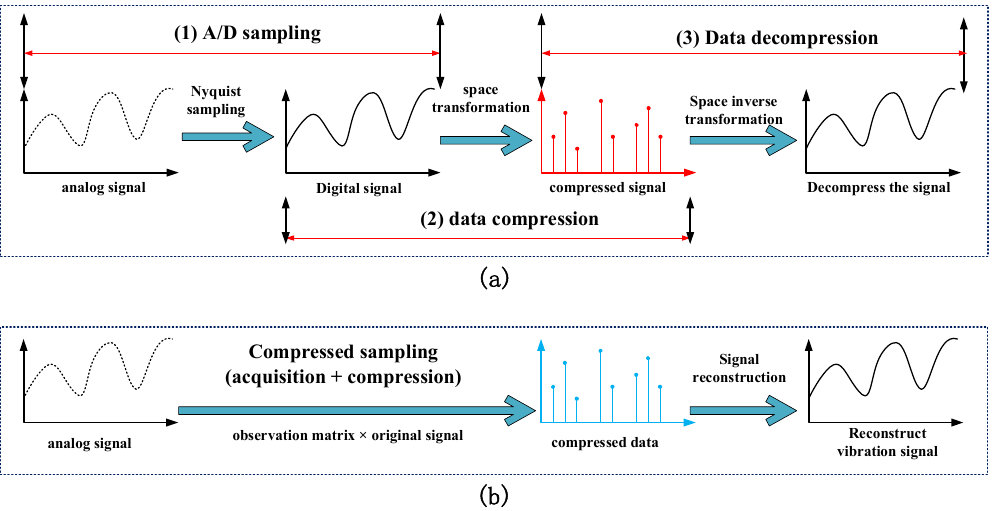
Figure 1. Diagram of traditional compression and compressed sensing data acquisition: ( a ) traditional compression process; ( b ) compressed sensing process.